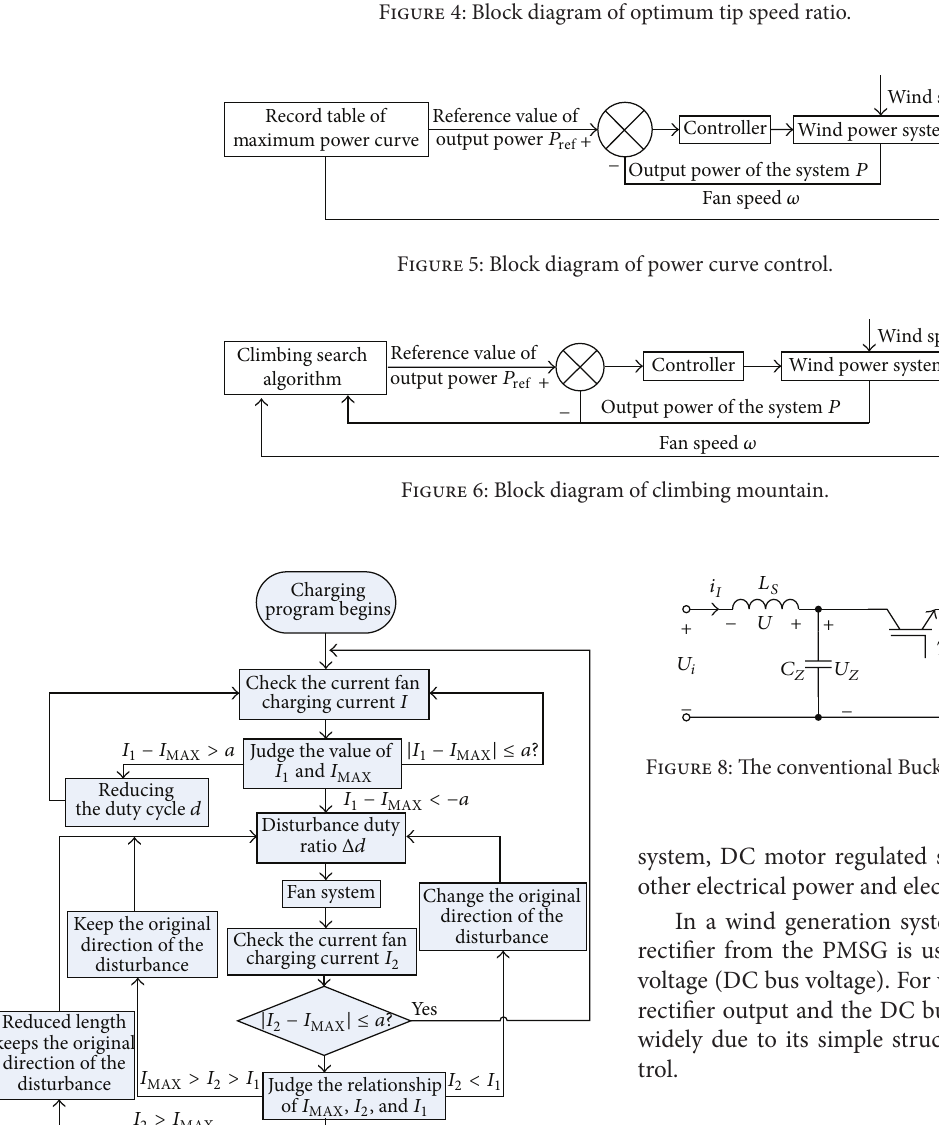
Figure 4: Block diagram of optimum tip speed ratio.